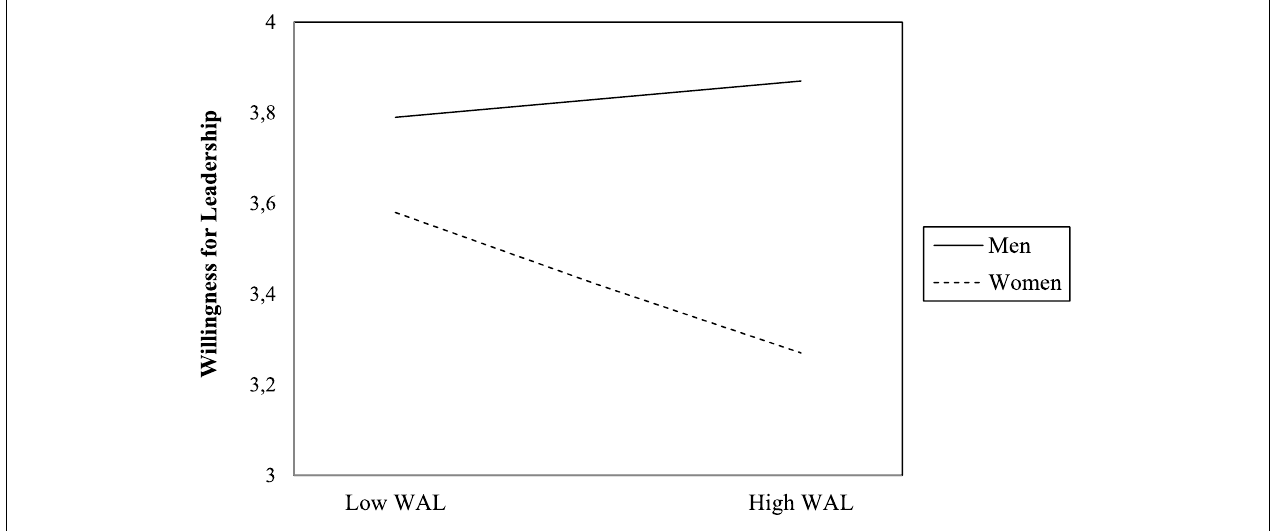
FIGURE 2 | Worries about leadership’s effect to predict women’s and men’s willingness for leadership in Study 1.